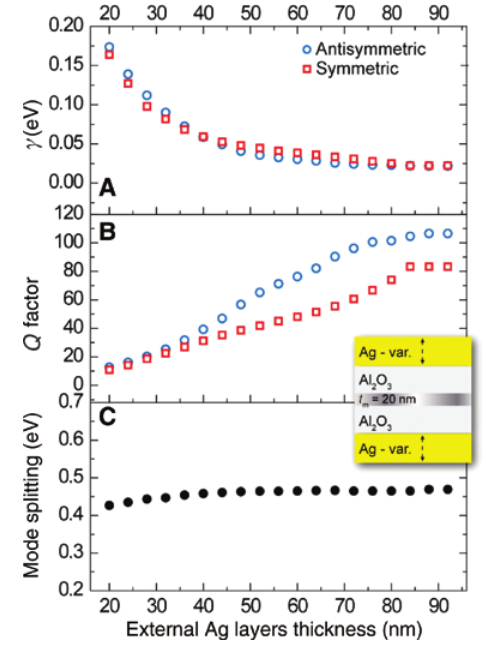
Figure 3: Dependence of the cavity resonances on the thickness of the external Ag layers. SMM simulations of the (A) linewidth, (B) quality factor, and (C) mode splitting of a MIMIM system with 20 nm thickness of the central metal layer as a function of the thickness of the external metal layers.